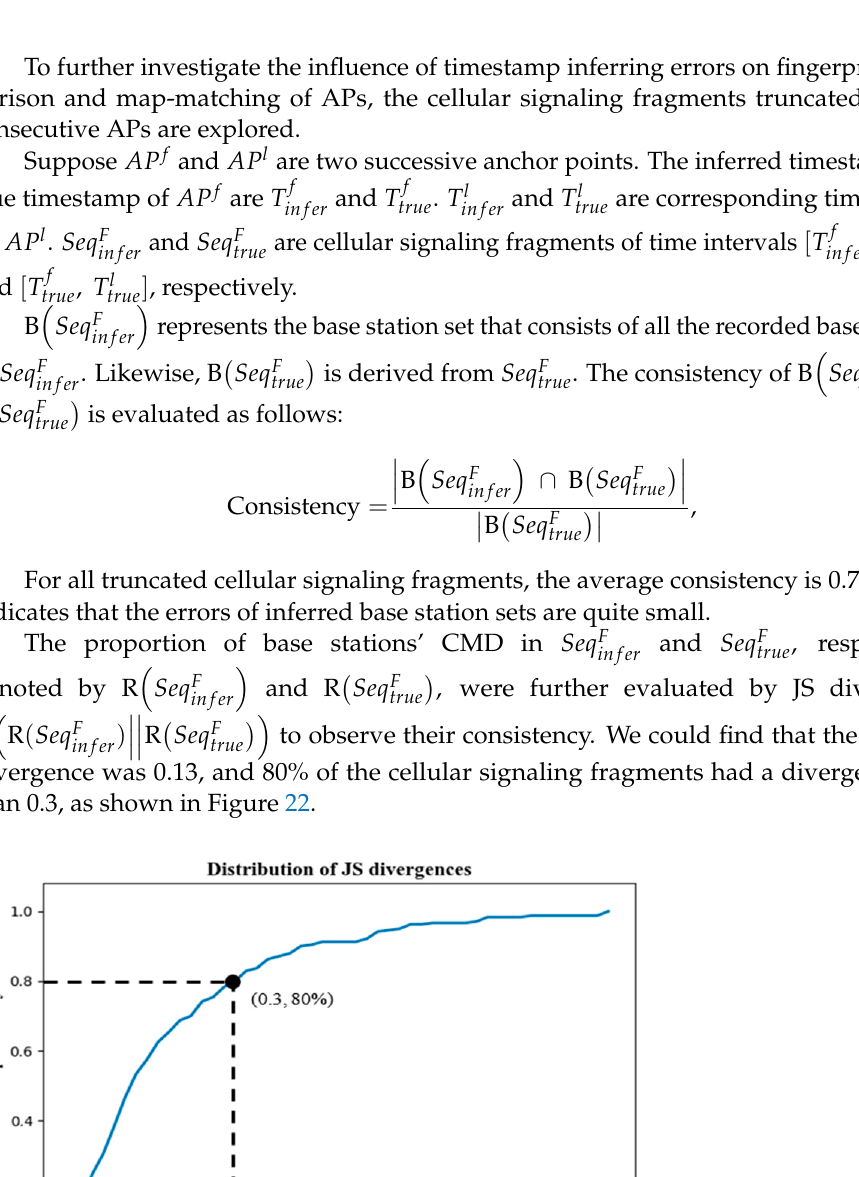
(cid:12)(cid:12) (cid:12) (cid:16) (cid:1)(cid:17) (cid:0) (cid:12) (cid:12) ) Seq F R ( Seq F . (cid:12) R true infer